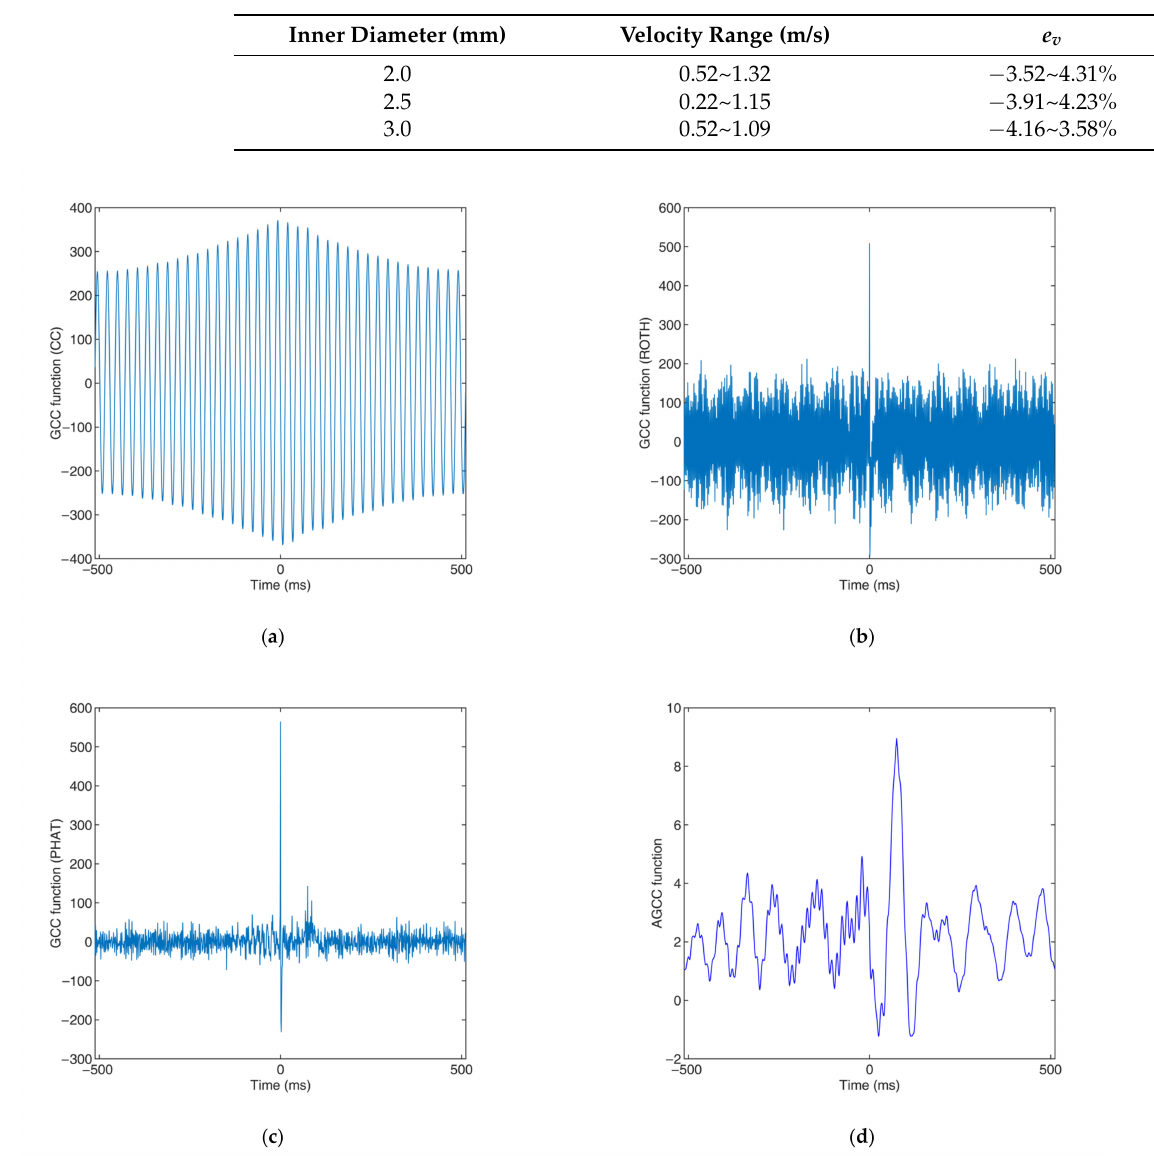
Table 2. Velocity measurement results.